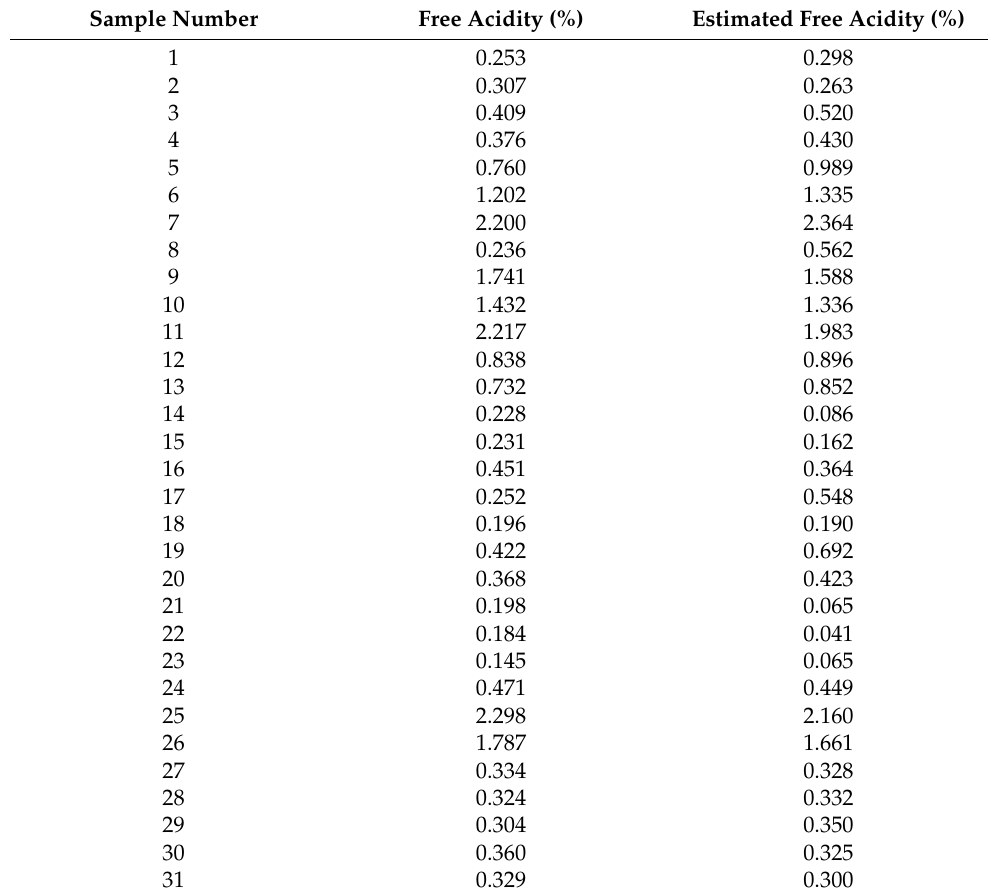
Table 1. Estimated values of the free acidity for the subset of olive oil samples featuring a peroxide index < 20 meq O 2 /kg oil.